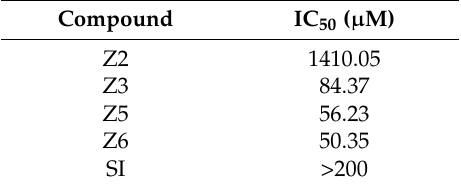
Table 3. IC 50 values for cysteine proteases from epimastigotes of Trypanosoma cruzi strain